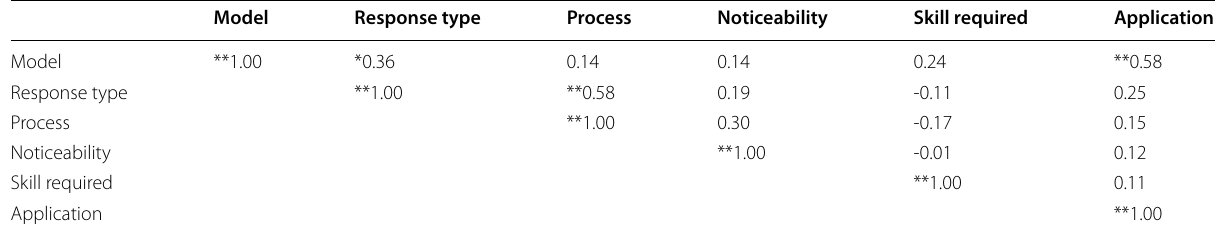
Table 3 Table of correlations, Pearson’s r , between individual categories on surveyed manuscripts. Stars represent significant p -values. One star: p < 0.05 , two stars: p <